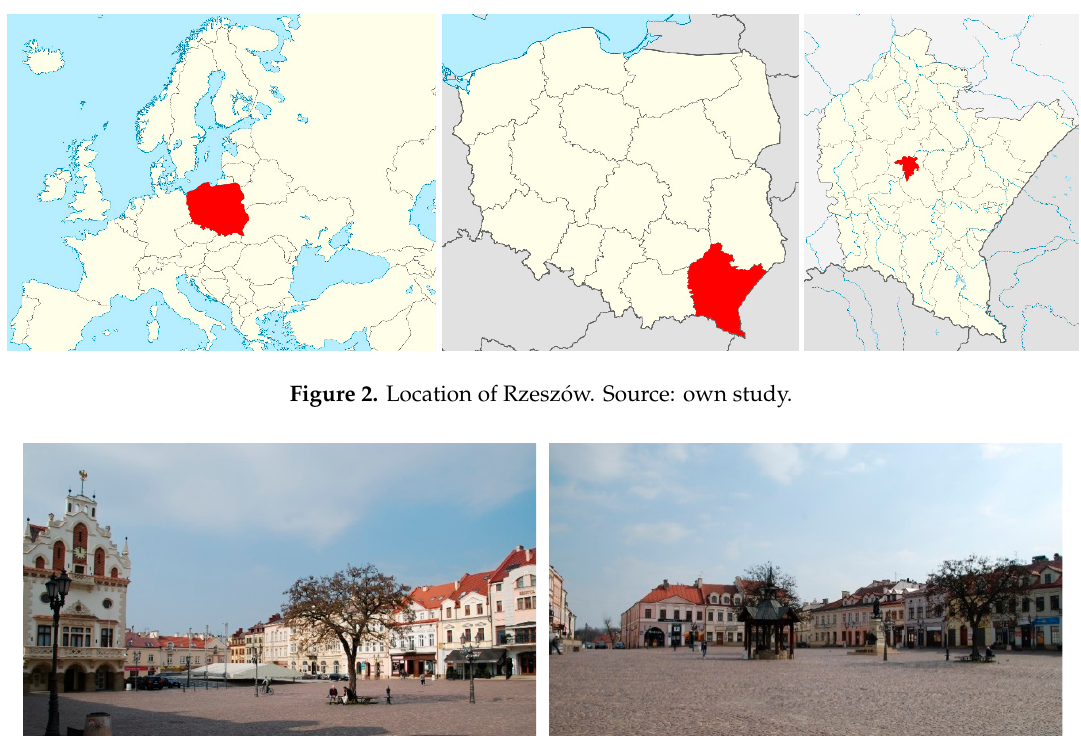
Figure 3. Main Market Square in Rzeszów. Source: own study.